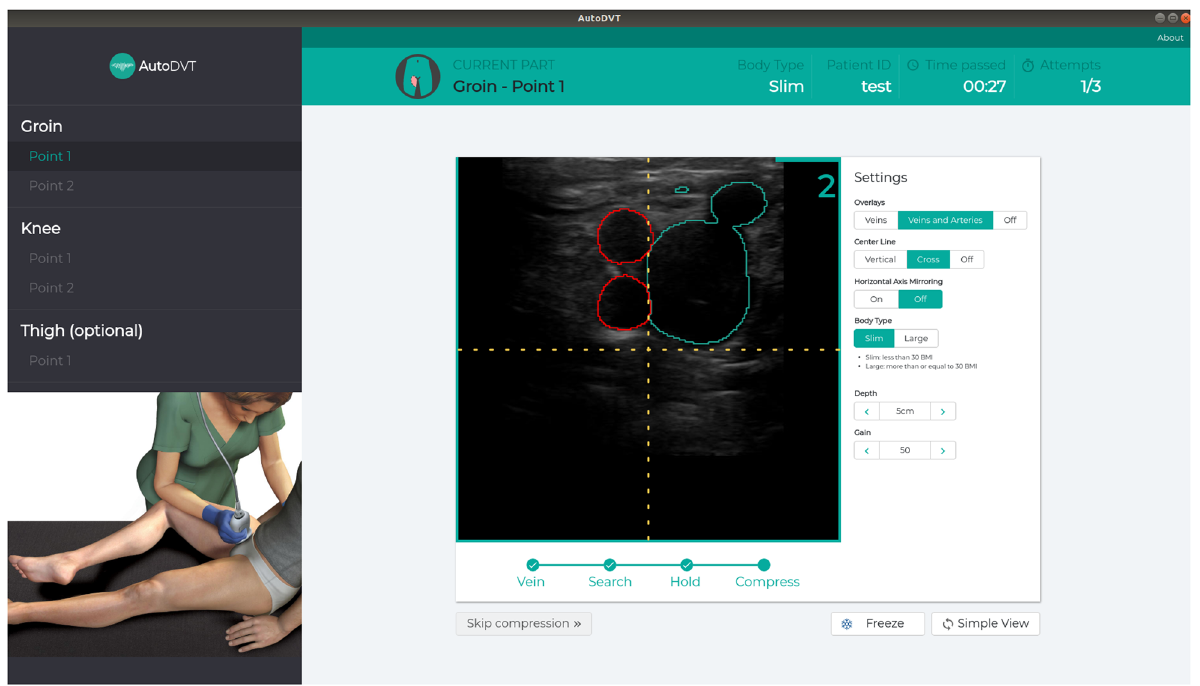
Fig. 10 Prototype implementation user interface. The AutoDVT software instructs users to locate a given landmark, instructs to perform a correct compression and evaluates the result